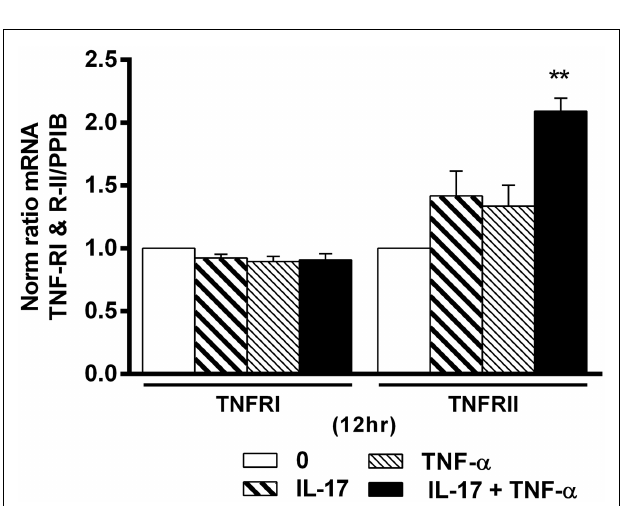
FIGURE 6 | Effects of Il-17A andTNF- α onTNFRI andTNFRII expression are shown . hMSCs were cultured in osteogenic medium in the presence or absence ofTNF- α 1ng/ml and/or IL-17A 50ng/ml. Gene expression ofTNFRI andTNFRII were measured by qRT-PCR at 12h. Results were